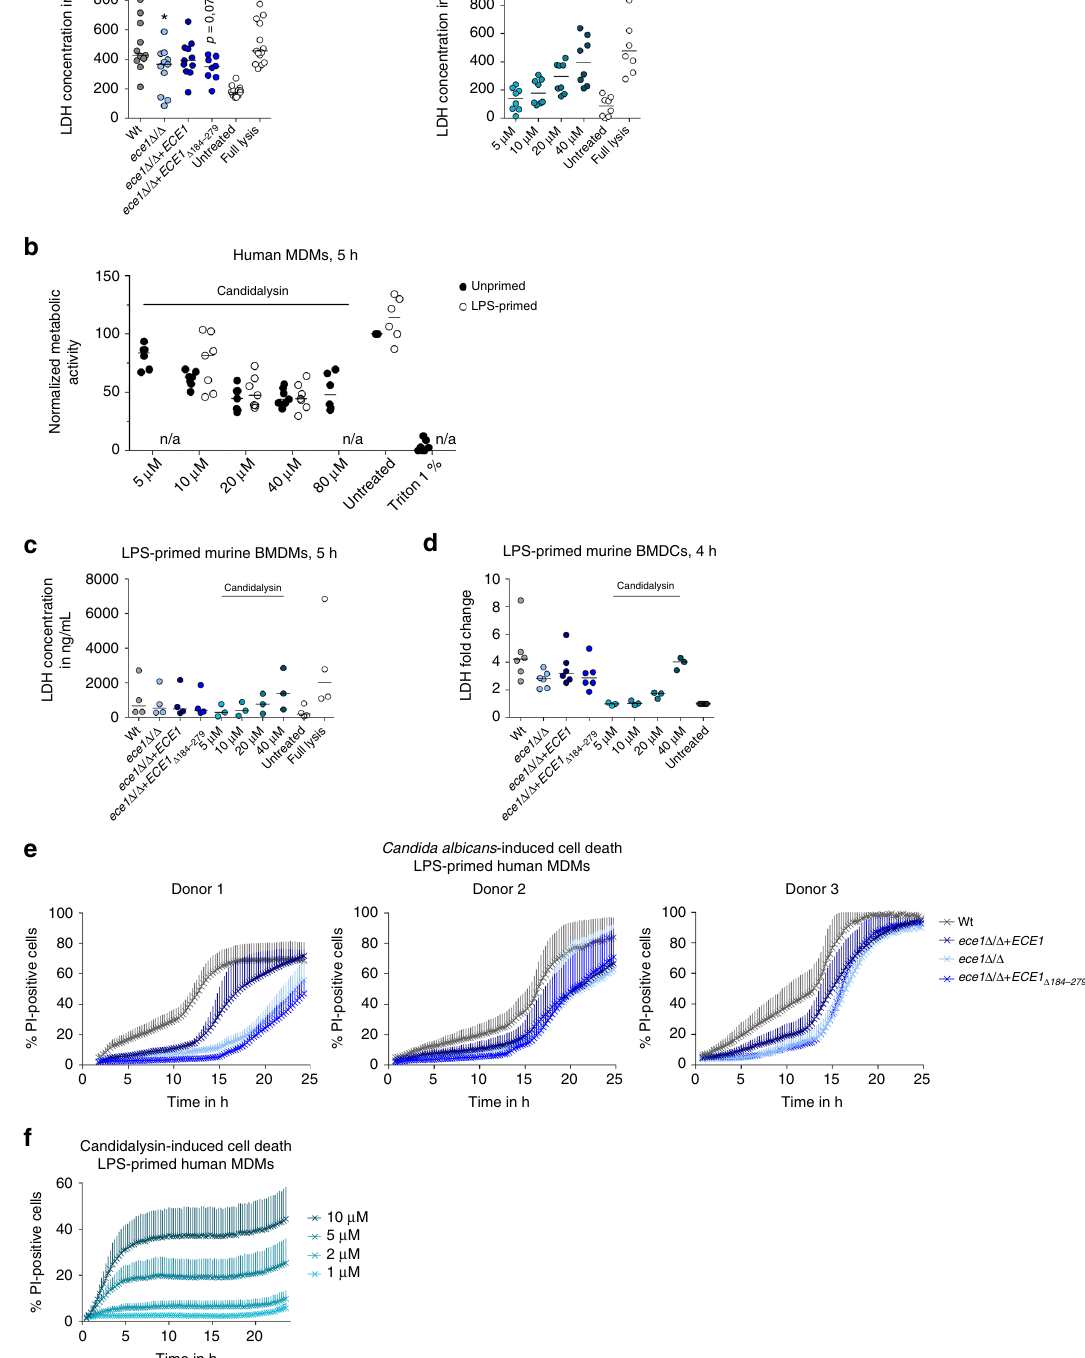
Fig. 8 Candidalysin-dependent damage of hMDMs. a , c , d Macrophage lysis was quanti fi ed by measuring LDH release in a unprimed hMDMs or LPS- primed c mBMDMs or d mBMDCs that were infected with C . albicans Wt, re-integrant ( ece1 Δ / Δ + ECE1 ) or mutant strains ( ece1 Δ / Δ , ece1 Δ / Δ + ECE1 Δ 184 – 279 ) (MOI 6) for 5 or 24 h and in LPS-primed a hMDMs, c mBMDMs, or d mBMDCs that were incubated with synthetic Candidalysin for 5 h. b Metabolic activity of LPS-primed or unprimed hMDMs treated with synthetic Candidalysin for 5 h was measured using XTT. 1% Triton X-100 was added as a positive control. e , f Macrophage damage over time was assessed by quantifying propidium iodide (PI)-positive cells in LPS-primed hMDMs infected with e C . albicans Wt, re-integrant ( ece1 Δ / Δ + ECE1 ) or mutant strains ( ece1 Δ / Δ , ece1 Δ / Δ + ECE1 Δ 184 – 279 ) (MOI 6) or f incubated with synthetic Candidalysin. a – d Values are represented as scatterplot with median of at least three different donors ( n ≥ 3). For statistical analysis, a one-way ANOVA with Dunnett ’ s multiple comparison test was used. * p ≤ 0.05, signi fi cance compared to Wt infection. e The results of three different donors are displayed separately due to strong donor variability. Data are shown as mean + SD of two independent positions in two wells. f Data are shown as mean + SD of six independent